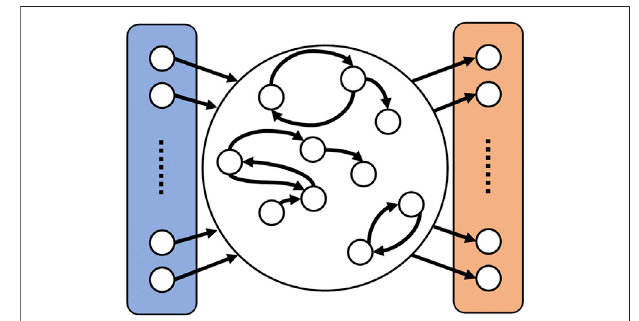
FIGURE 4 | Schematic representation of an ESN. On the left side (colored in blue) is the input layer where the input signal u bias b in arefedin.Thereservoirisrepresentedasthelargecircleinthemiddle, where the small circles are the nodes. The output layer on the right (coloredinorange) providesthereservoirsignals s → → → (cid:2) [ b ; s ; u ] used for computing the output y x n out n n